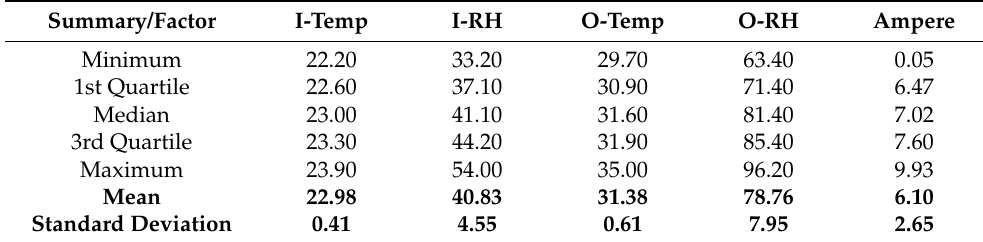
Table 5. Summary of bad airflow condition.